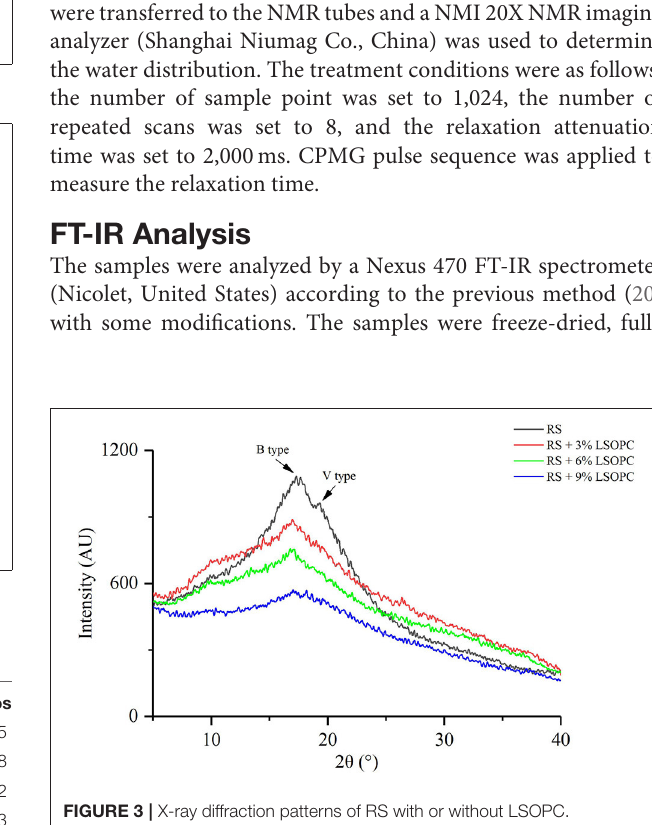
FIGURE 3 | X-ray diffraction patterns of RS with or without